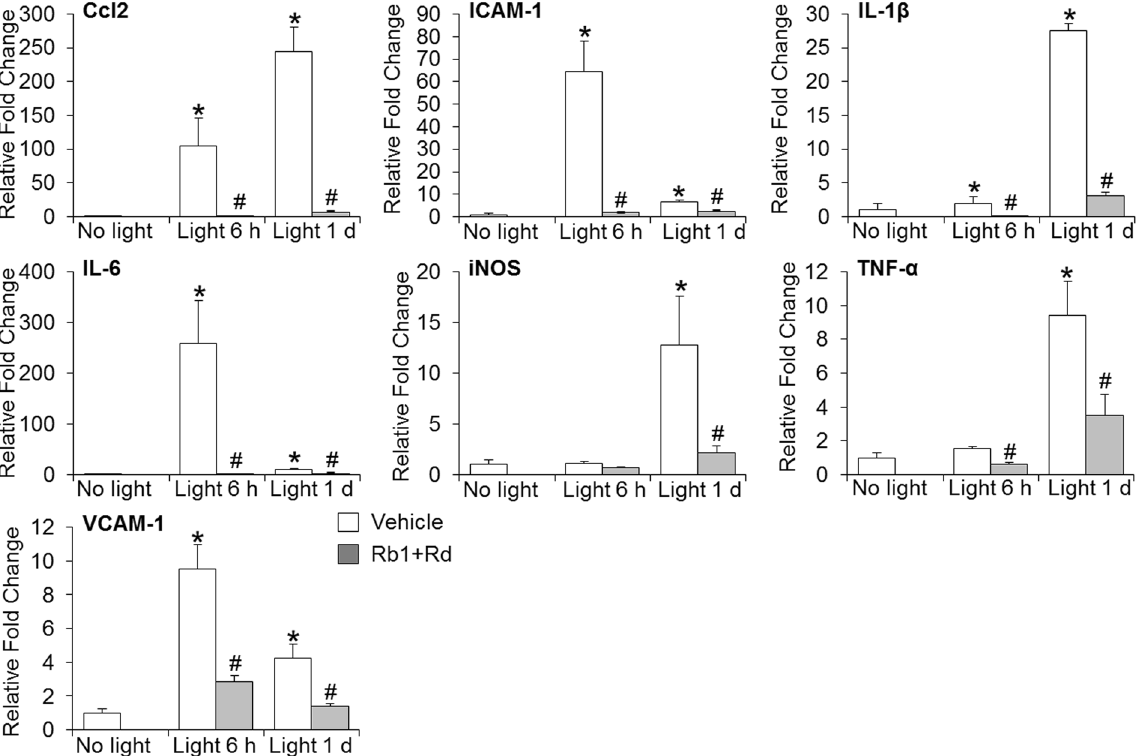
Figure 5. Combined treatment of Rb1 and Rd mitigated the retinal expression of proinflammatory and cell adhesion genes in bright light-exposed mice. Retinas collected from vehicle-treated mice unexposed to bright light (No light) and bright light-exposed mice treated with vehicle (Vehicle) or combination of Rb1 and Rd (Rb1 + Rd) 6 h and 1 d after illumination. Real-time PCR analyses were subsequently performed to examine the retinal expression of Ccl2, ICAM-1, IL-1 β , IL-6, iNOS, TNF- α and VCAM-1 (n = 4–6 per group). Relative fold change of each gene was normalized against that from vehicle-treated mice unexposed to bright light. The data were expressed as the mean ± S.E.M. * Compared to that from No light, p < 0.05; # compared to that from Vehicle, p <